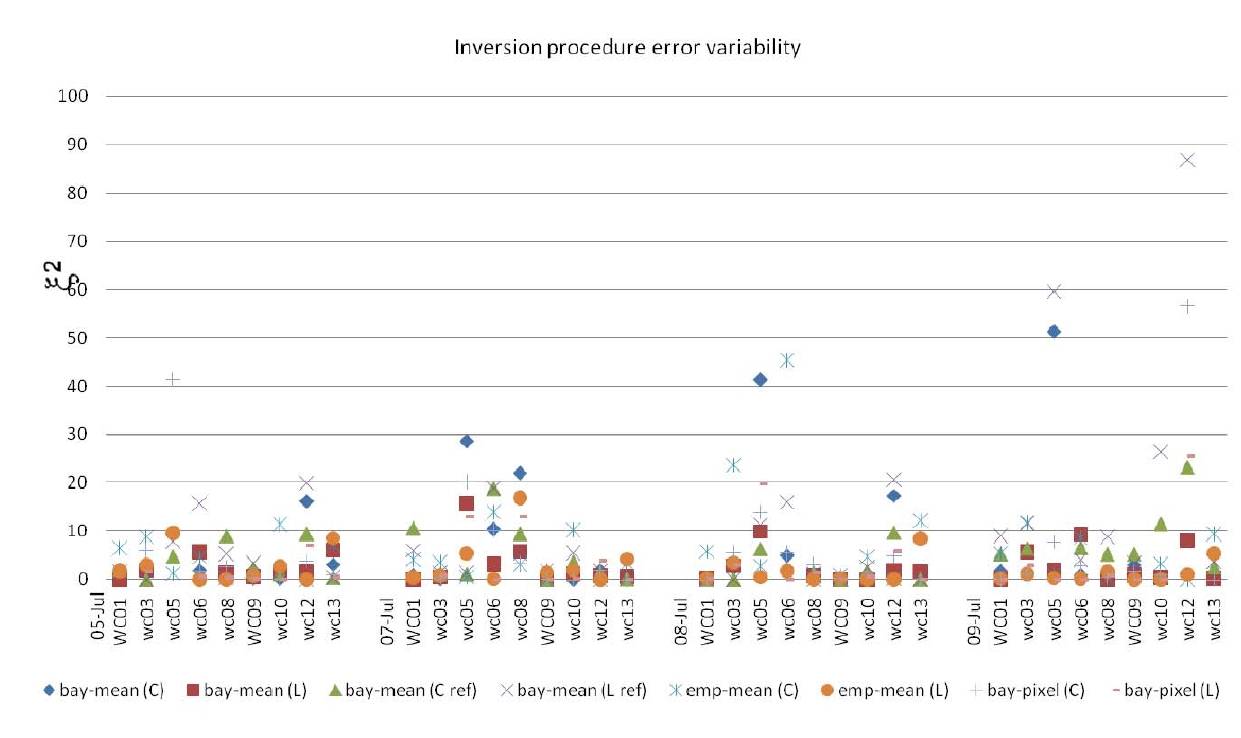
Figure 2 . The error 2 ξ variability due to the different algorithms and acquisition dates (5 t July, 7 July, 8 July and 9